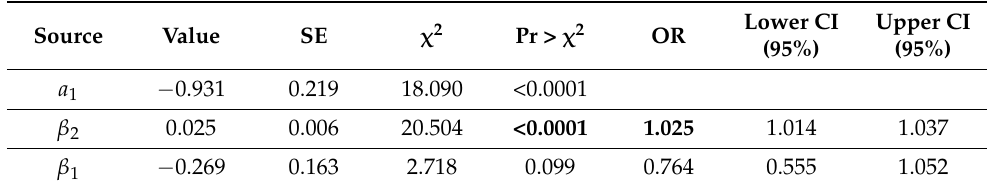
Table 3. The parameters of the logistic model characterizing the relationship between the variable Y 1 : “Have you been infected with COVID-19?” and the variables X 1 and Z 1 (Model 1). Bold values indicate a statistically significant impact.